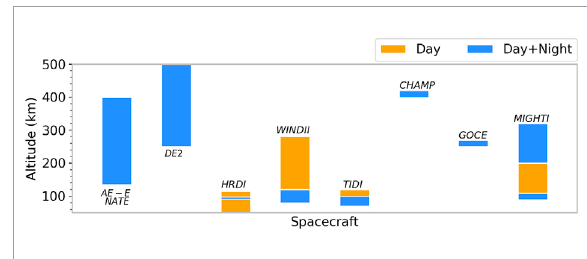
FIGURE 2 Altitudinal and diurnal coverage of the past ITM missions with neutral wind measuring